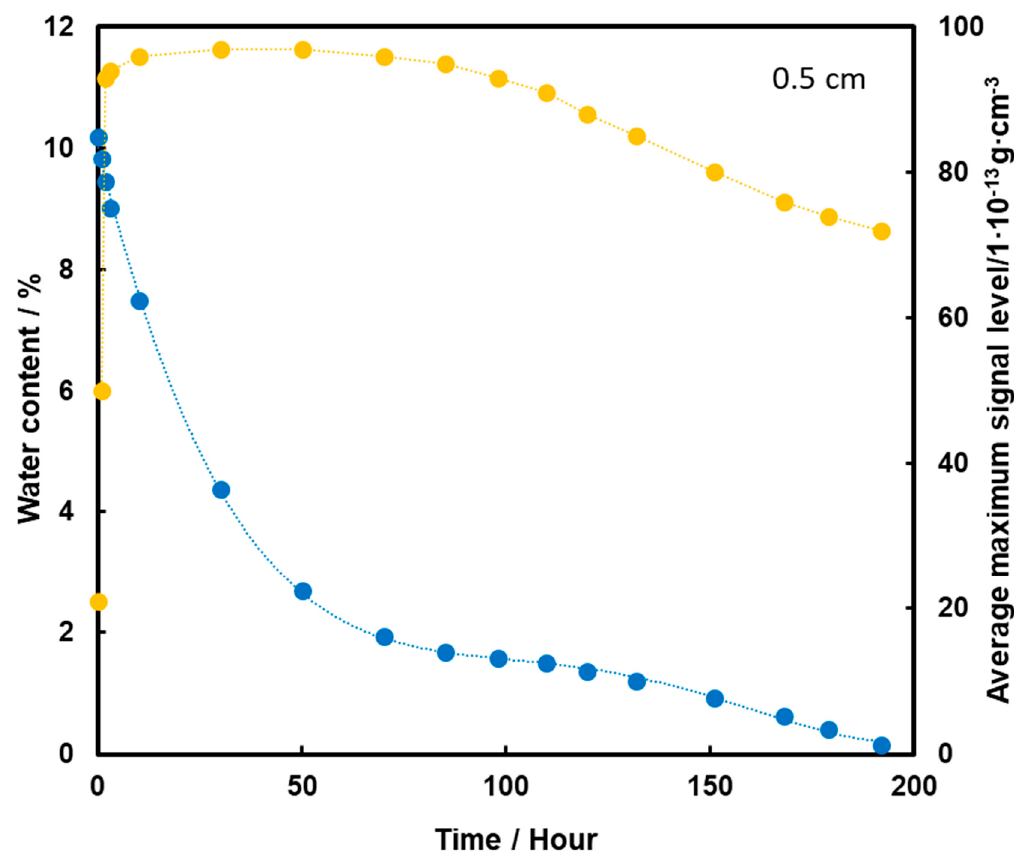
Figure 8. Dependence of the mean maximum TNT signal ( • ) on the amount of water ( • ) in the substrate for the TNT sample at a depth of 0.5 cm, at a temperature of 50 °C.